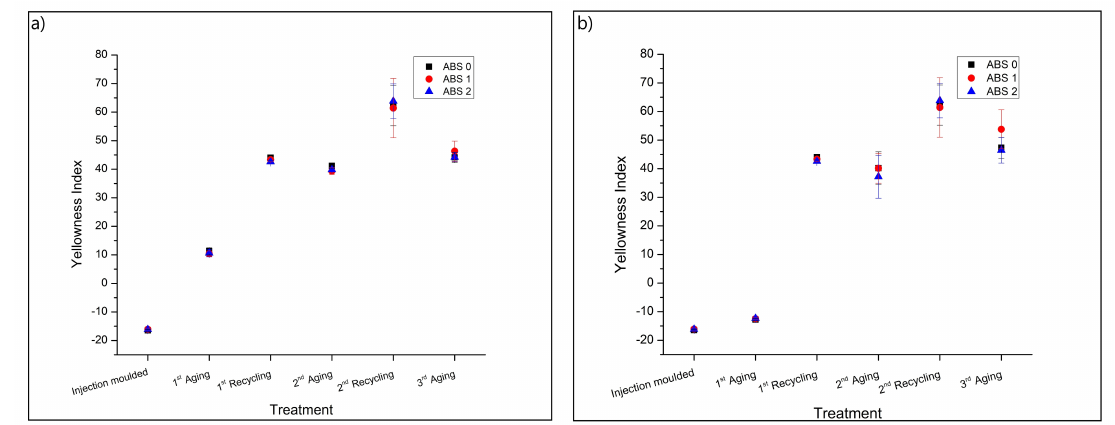
Figure 7. Yellowing index (YI) measurements. ( a ) UV-exposed side and ( b ) unexposed side for the sample types covered in Table 1, following the procedure in Figure 1.